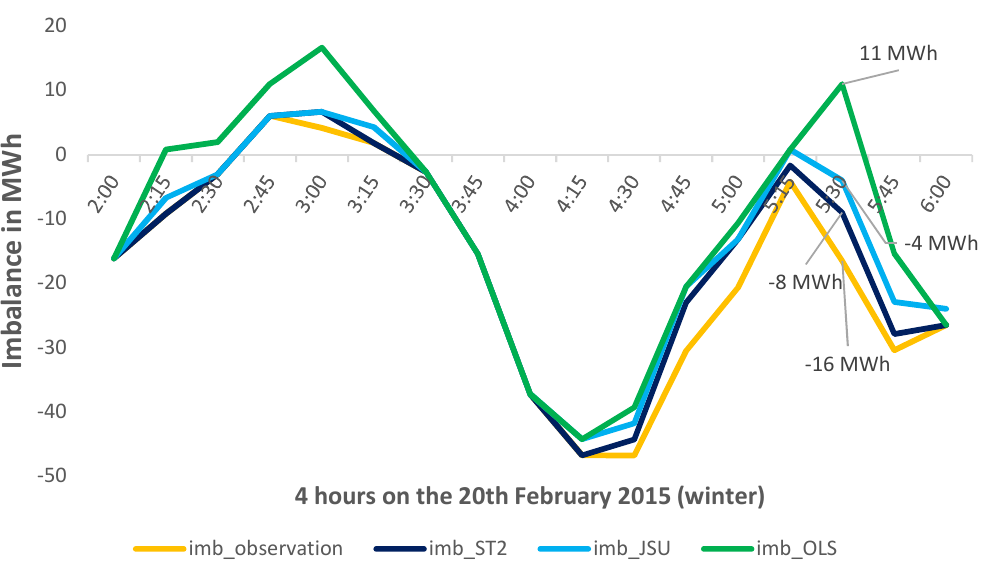
Figure 6. Illustrative imbalances with/without trading in backtesting.